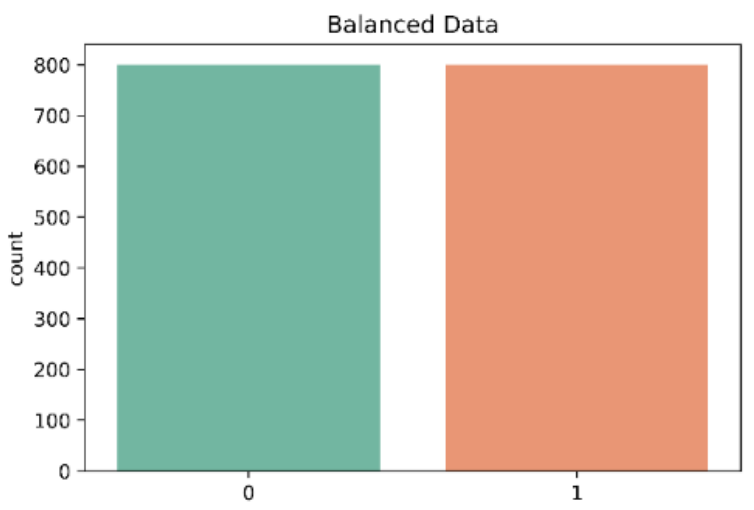
Figure 6. Distribution of each class in the dataset after Borderline-SMOTE; 0 = Control and 1 = Stroke.